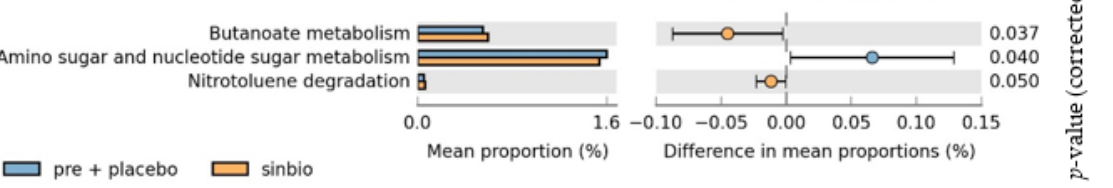
Figure 7. Changes in the functional prediction of gut microbiota after synbiotic supplementation.